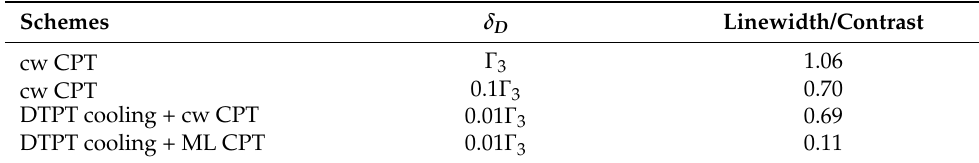
Table 1. The linewidth/contrast values of CPT signals based on different schemes and Doppler shifts.